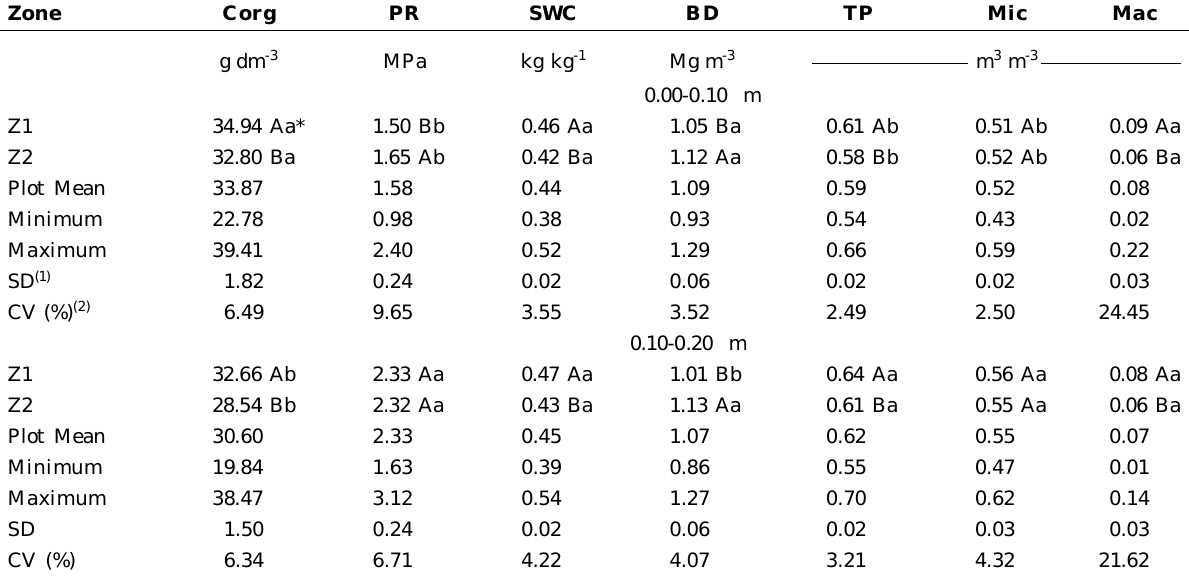
*Means followed by different letters indicate significant difference (p<0.05) by Student’s t- test. Upper case letters compare zones in the same layer and lower case letters compare layers at same zone. (1) SD: standard deviation; (2) CV: coefficient of variation.